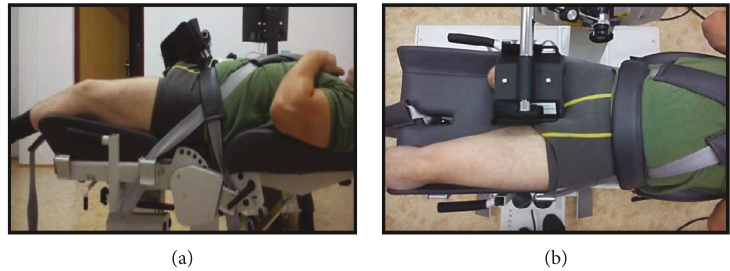
Figure 2: Test position for the hip fl exor and extensor muscles. Side and top view.